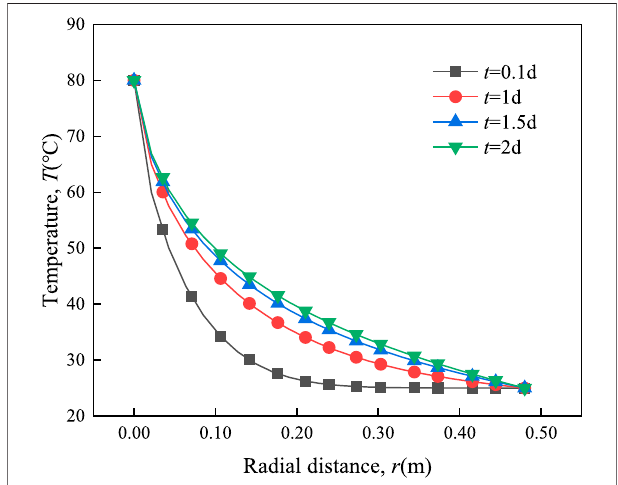
FIGURE 12 | Variation of temperature with radial distance at different times at height z = 0.25 m.